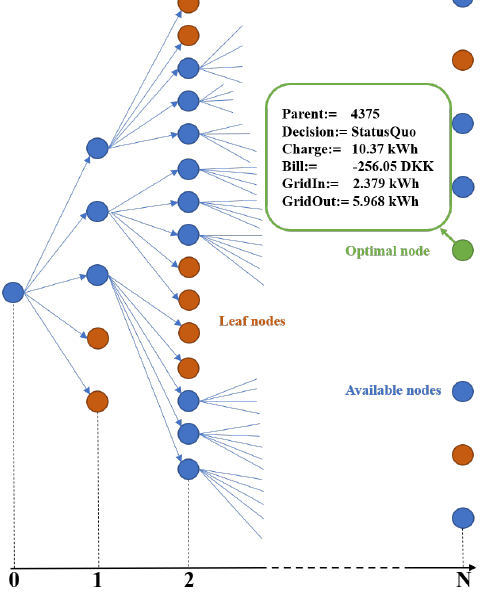
Figure 3. An example of a decision tree for the optimal energy management